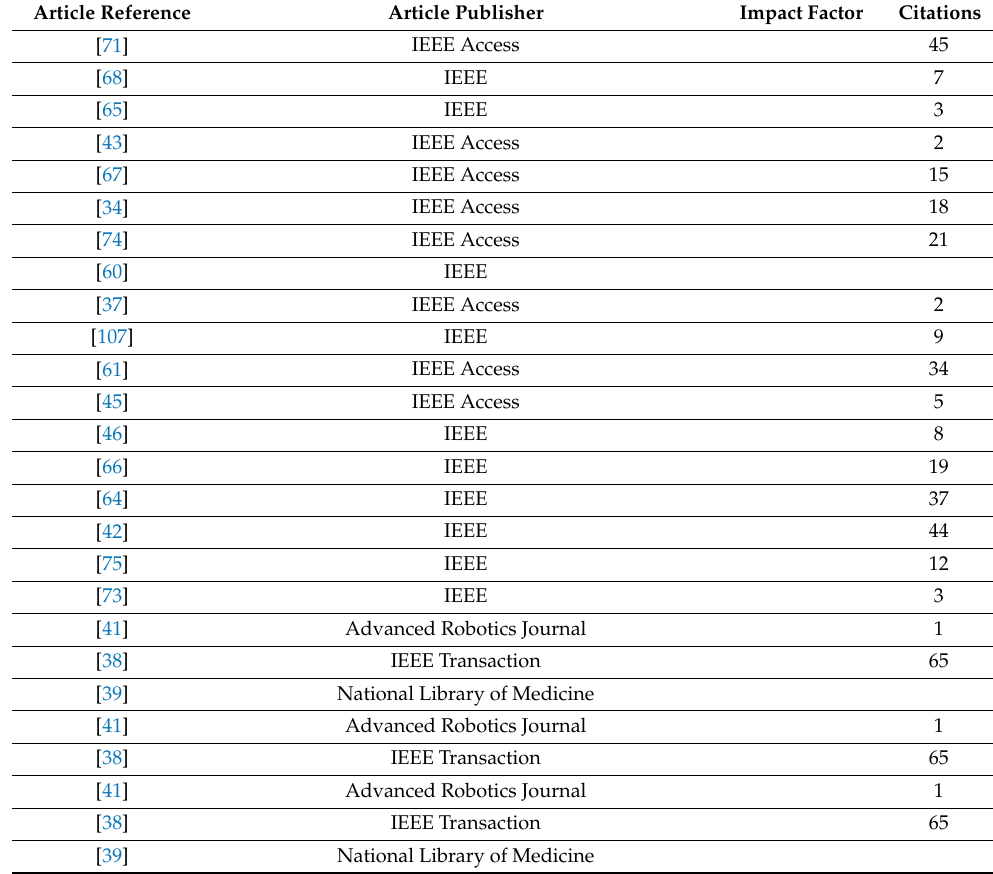
Table 4. Impact factor and citation analysis of reviewed